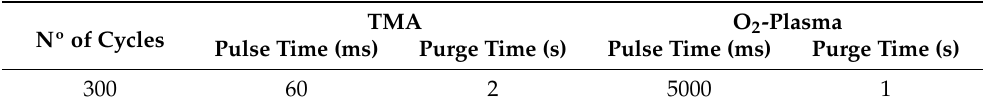
Table 1. PEALD recipe for the Al 2 O 3 ultra-thin films. Nº of